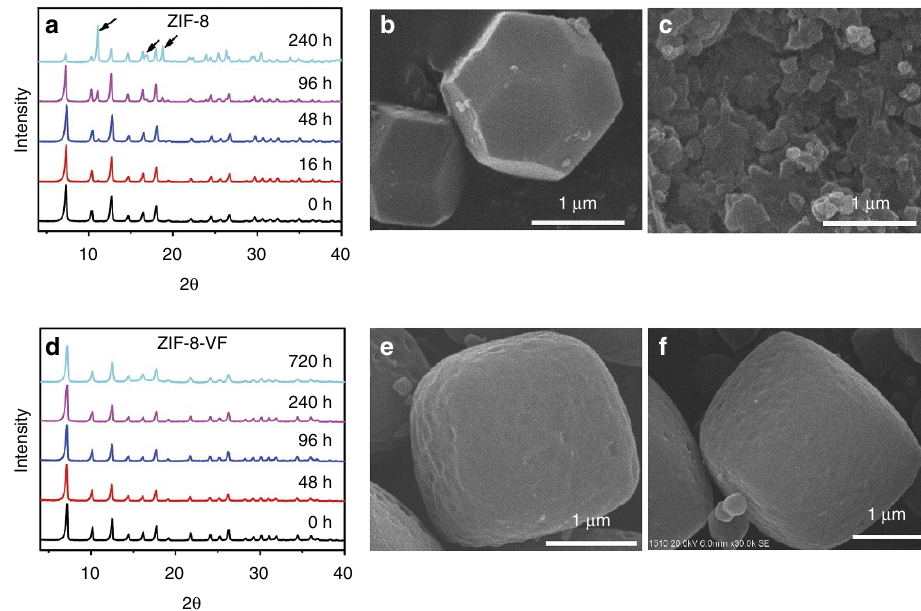
Figure 5 | Stability comparison of ZIF-8 and ZIF-8-VF. ( a , d ) Selected PXRD patterns of ZIF-8 and ZIF-8-VF ageing under 1atm of water saturated CO 2 at 45 (cid:2) C for different duration times. ( b , c ) SEM images of ZIF-8 before and after ageing under the above conditions for 240h. ( e , f ) SEM images of ZIF-8-VF before and after aging under the above conditions for 720h. Main peaks of unknown crystalline phase are marked with black arrows.